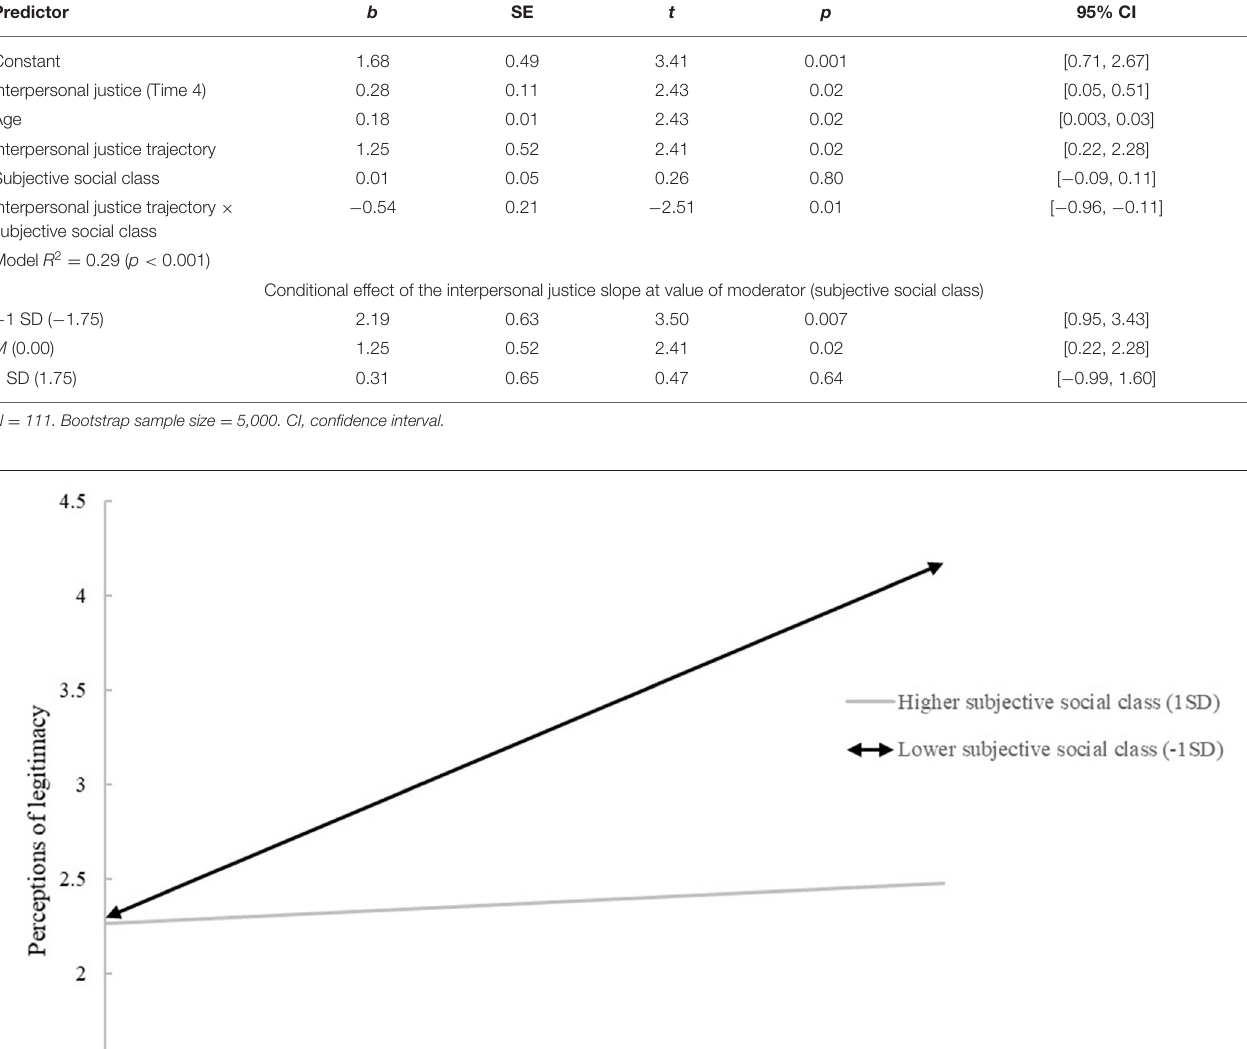
variable, and educational attainment or occupation status was the moderator variable. The interpersonal justice perceptions at Time 4 and age were control variables. We reported these a moderator, the main effect of interpersonal justice